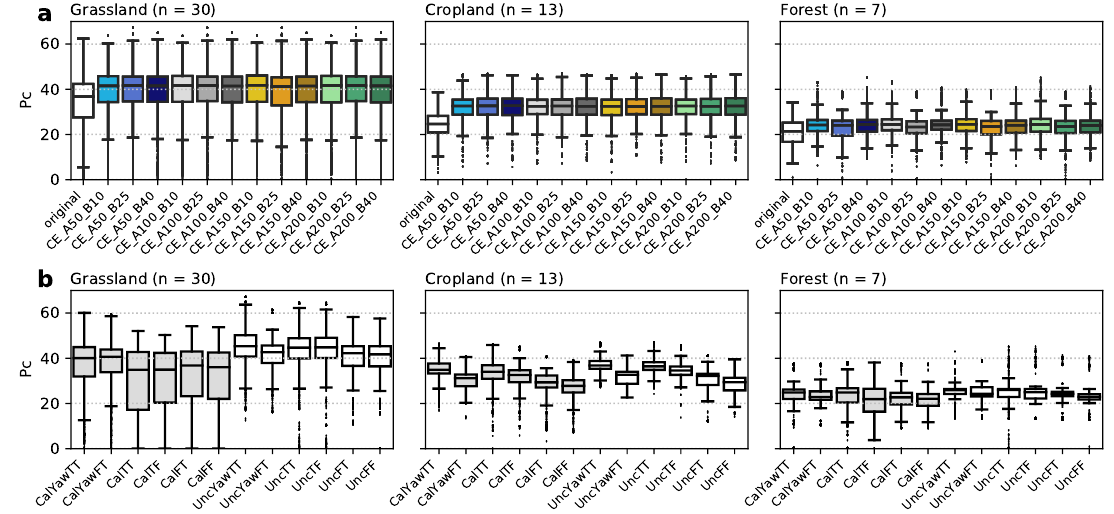
Figure 4. ( a ) Pc per contrast enhancement settings and land cover. The color groups stand for parameter A, their different brightness levels mark parameter B ( b ) Pc per combination of IMU data inclusion, geometric camera calibration, and pre-selection options (see abbreviations in Table 1). Gray shades highlight calibrated and on-job geometric camera